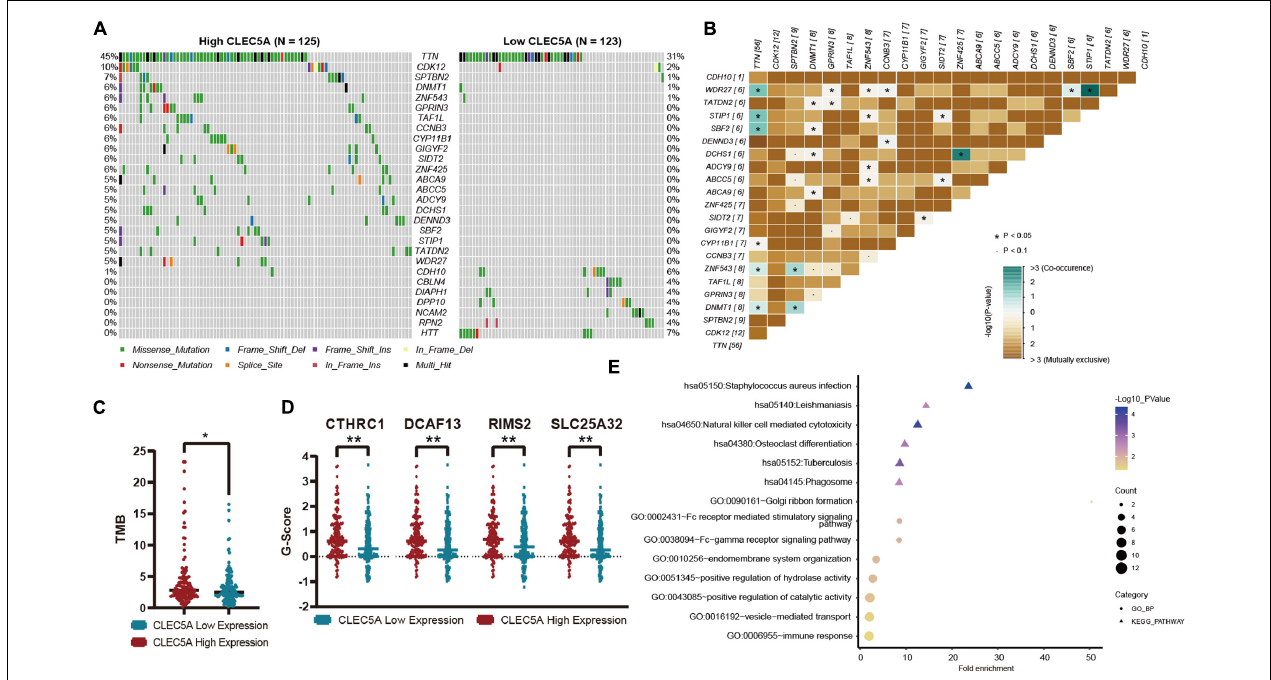
FIGURE 7 | (A) Mutation genes with significant difference between high- and low-expression CLEC5A groups. (B) Analysis of co-mutation and exclusive mutations in the CLEC5A overexpression group. (C) The difference of tumor mutational burden (TMB) levels in high- and low-expression CLEC5A groups. (D) Genes with significantly increased copy number variation in CLEC5A overexpression group. (E) Functional analysis of genes with decreased copy number variation in CLEC5A overexpression group. ** p < 0.01; * p <